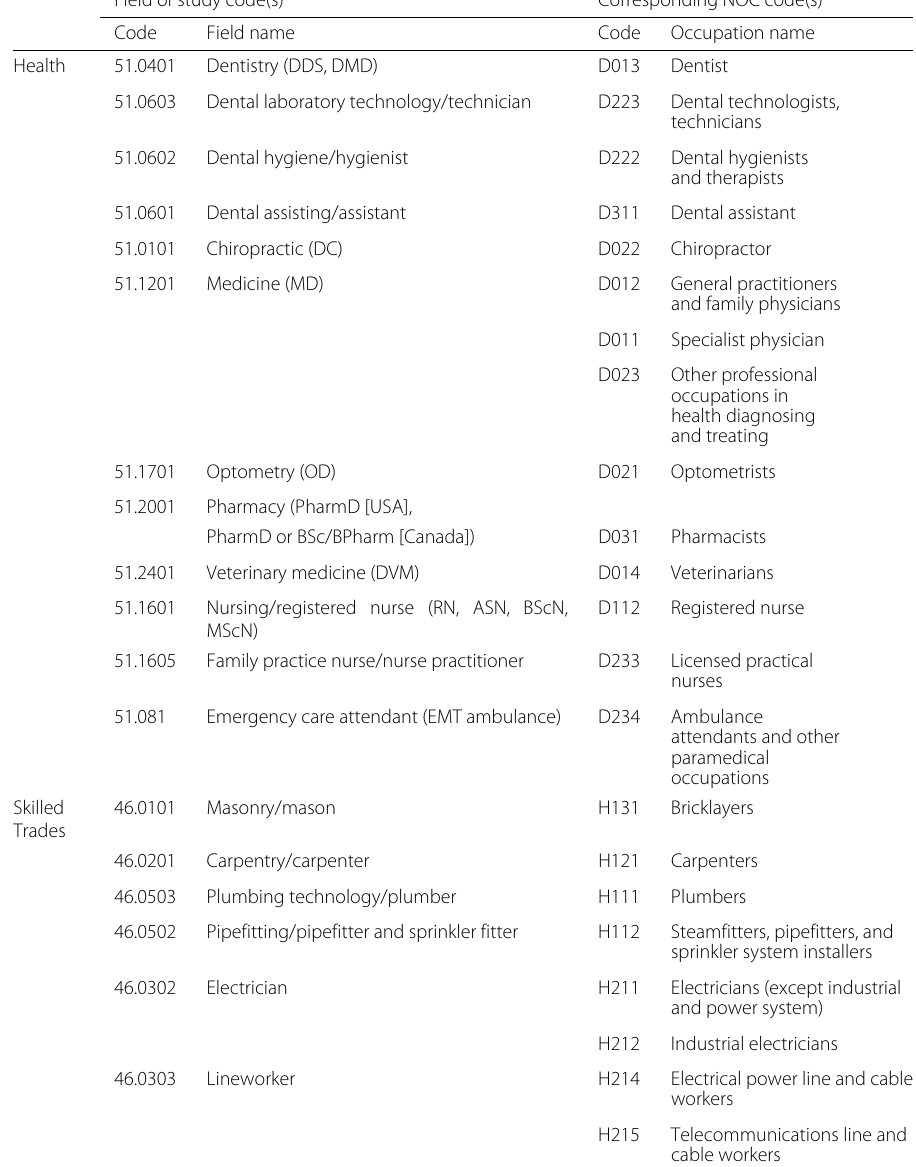
Table 16 Specialized occupation and field of study matches ( Continued